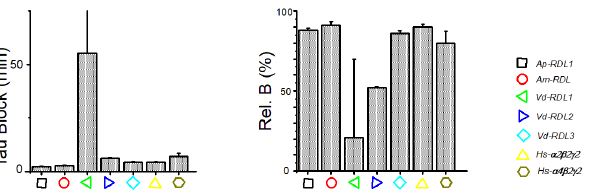
Figure 7. Tau-Block ( Left ) and Rel.B ( Right ) values for the inhibition by dieldrin of each RDL receptor from A. pisum and A. mellifera , RDL1, RDL2 and RDL3 from V. destructor , and α 2 β 2 γ 2 and α 4 β 2 γ 2 from H. sapiens deduced from the mono-exponential fit of the responses shown in Figure 6D.